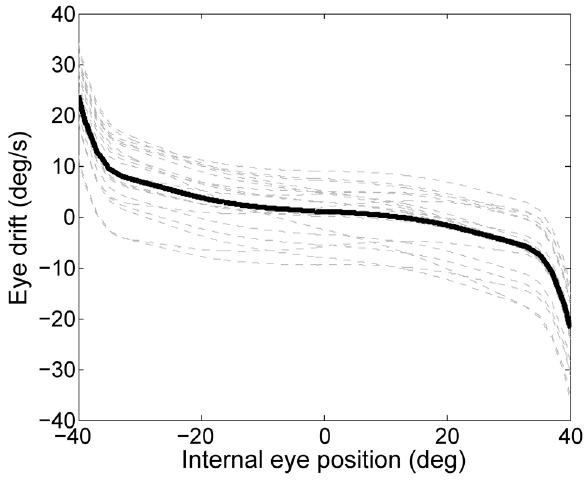
Figure 9. PV plots of random perturbations of tuned network. Effect of modifying the tuned values of g by a random fraction of 5% of the value used in figure 7. Dashed gray lines shows 20 different perturbations. The black solid line represents their mean.